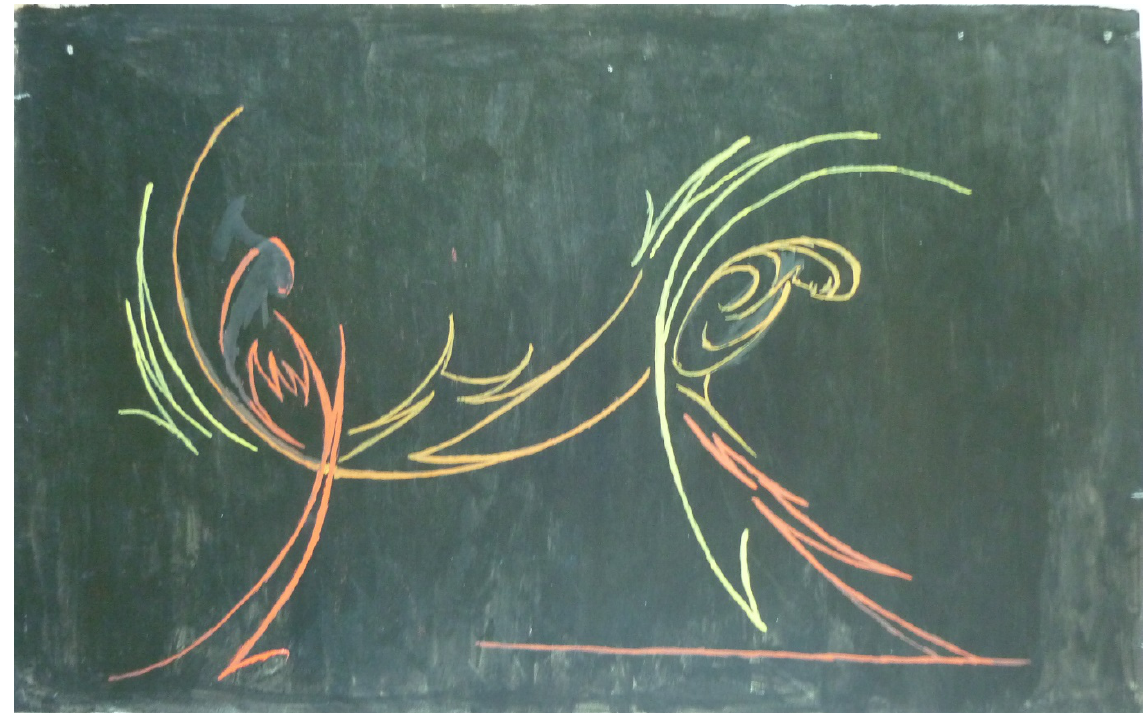
Figure 11. Bely’s drawing. 1913? Rudolf Steiner Nachlassverwaltung (Dornach).